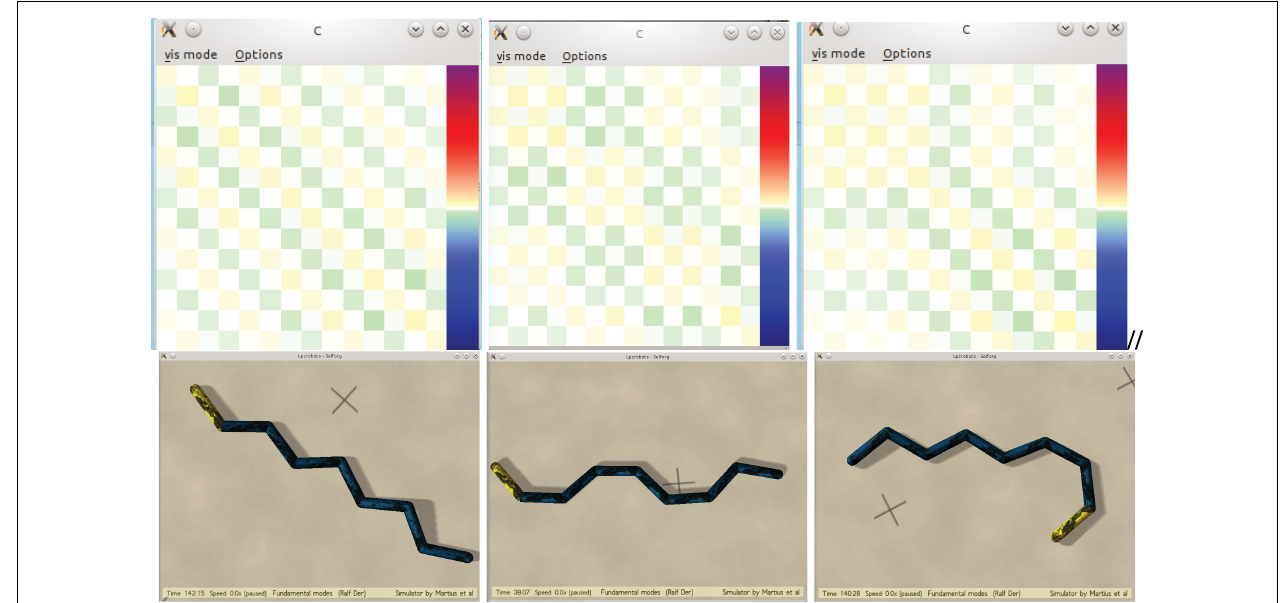
FIGURE 4 | The controller matrix C (above) with the Snake in various stable siderolling locomotion modes (below)